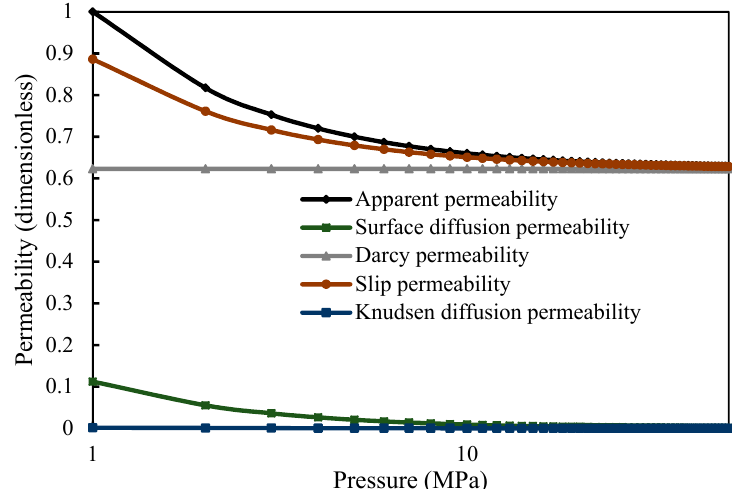
Figure 4. Relationship between dimensionless permeability and pressure.